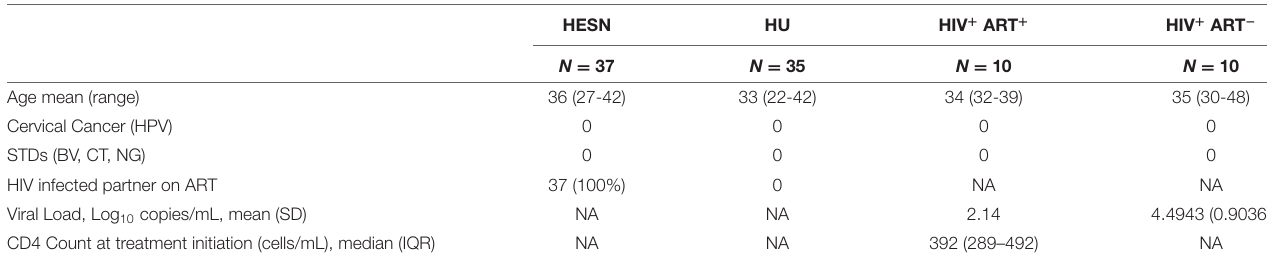
TABLE 1 | Demographic characteristics of the study population at